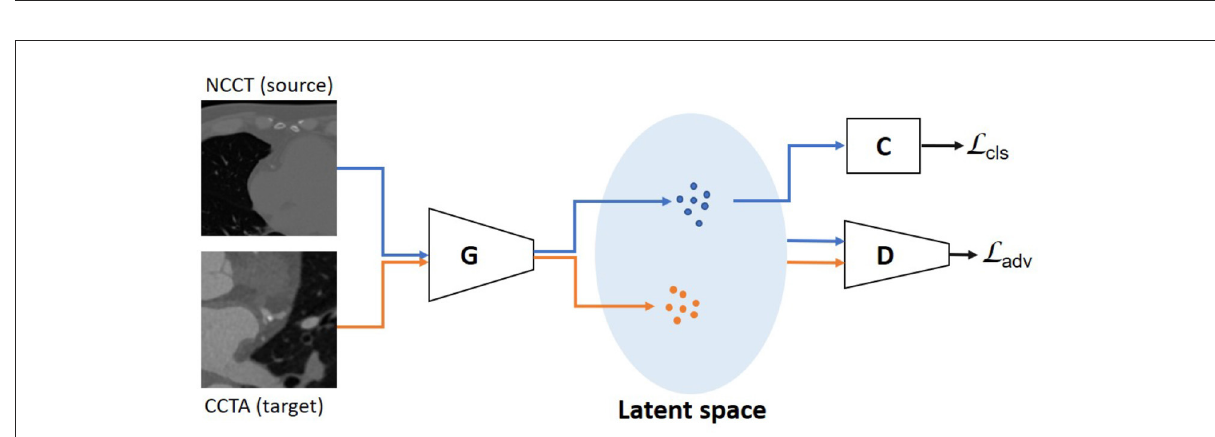
FIGURE2 Unsupervised domain adaptation with unpaired data is performed using an adversarial learning strategy. The discriminator is optimized to distinguish the features from NCCT (source) domain and CCTA (target) domain. The generator is trained to extract features with similar distributions for the two domains. The blue dots in latent space represent features from the source domain, the orange ones from the target domain. The L adv is used as the objective function and the L cls is used as a constraint, which is determined on the source domain using the